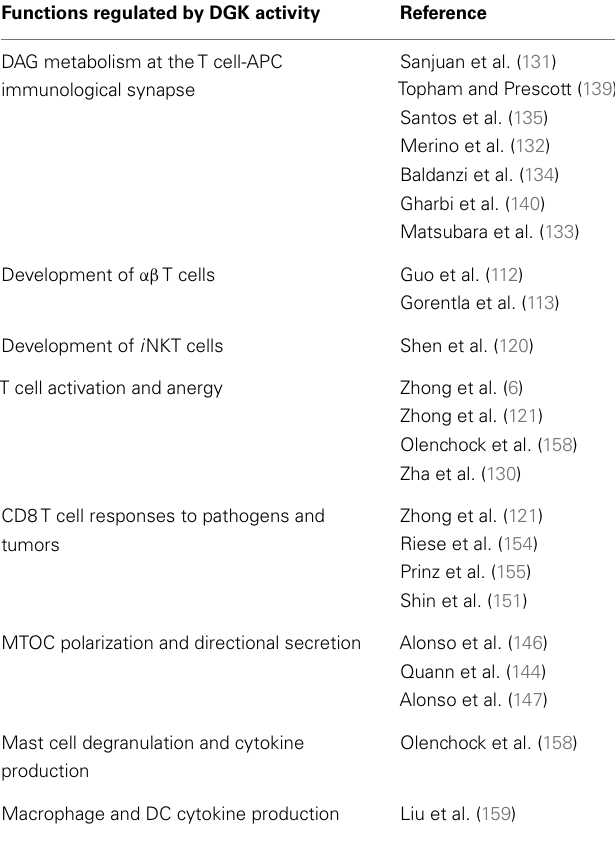
Table 1 | Biological functions of DGKs inT cells and other immune